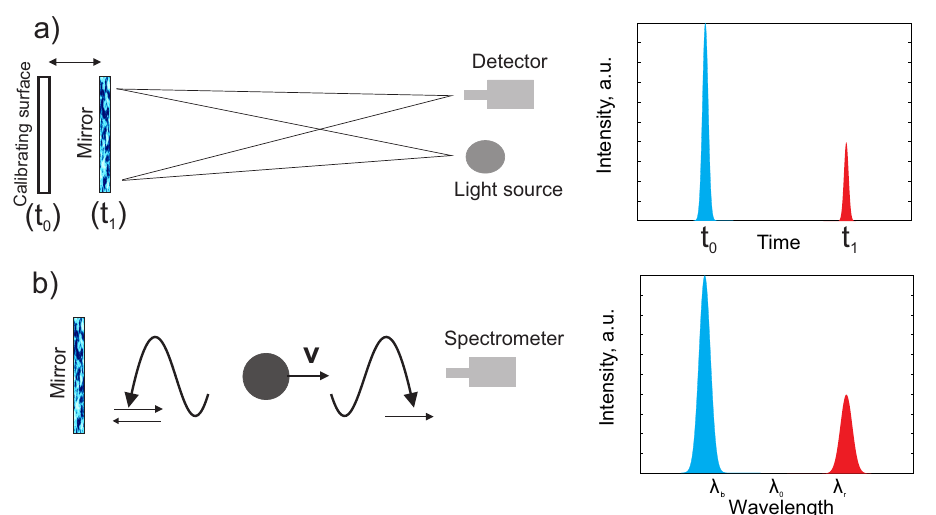
Figure 1. Principles of the Doppler-Shifted Reflectance Measurements (DSRM) in a plasma [1,2]. ( a ) Schematic picture of measurements in the laboratory using a light source and detector. ( b ) Schematic picture of measurements using the Doppler effect in front of the mirror using a high-resolution